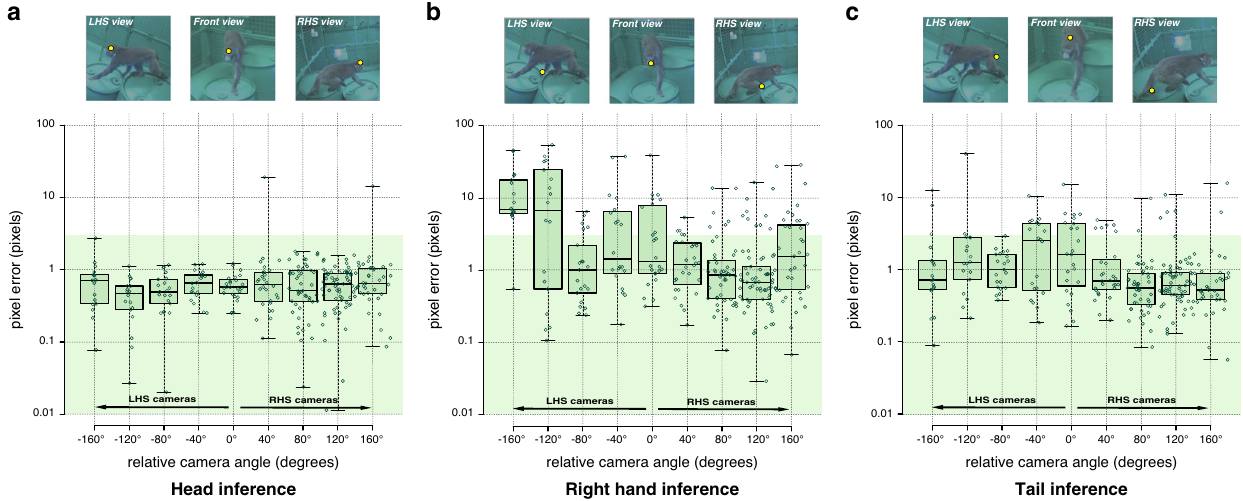
Fig. 5 View-dependent accuracy. The inference precision of landmark detection is view dependent. For the head ( a ) that is visible from most views, the precision is nearly uniform across views under the valid inference range (two pixel error, n = 344 images). In contrast, the right hand ( b ) is often occluded by the torso when seen from the cameras on the left-hand side of the macaque. The tail ( c ) corresponds more to the head inference with a slight degradation when the macaque is seen from head on. This results in non-uniform precision, i.e., the inference from the views on the right-hand side is more reliable than the other side. Boxplots represent median and 25th and 75th percentile respectively while whiskers extend to extrema.